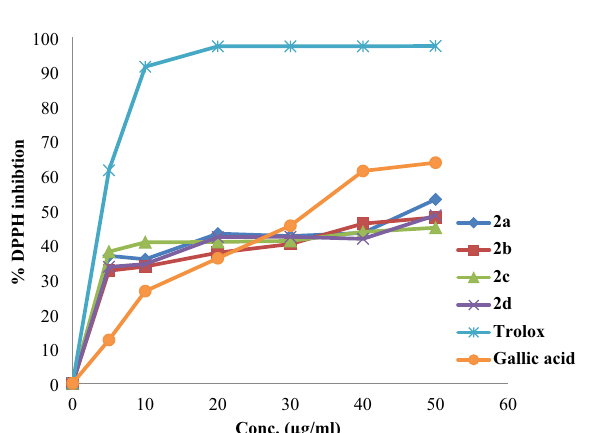
Table 1. IC 50 values of the synthesized compounds and acarbose regarding α-amylase and α-glycosidase inhibitory activities.